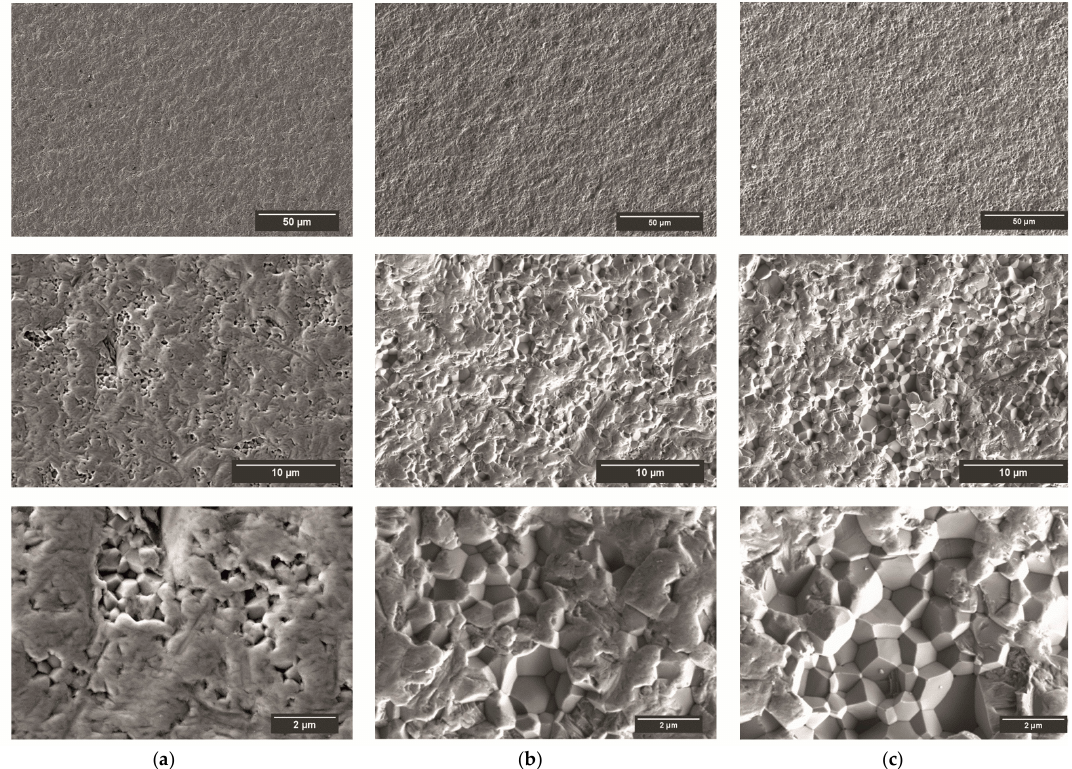
Figure 8. Field emission scanning electron microscopy (FESEM) images of the as-cut substrate surfaces of the sample: ( a ) O1; ( b ) HT1350; ( c ) HT1400.